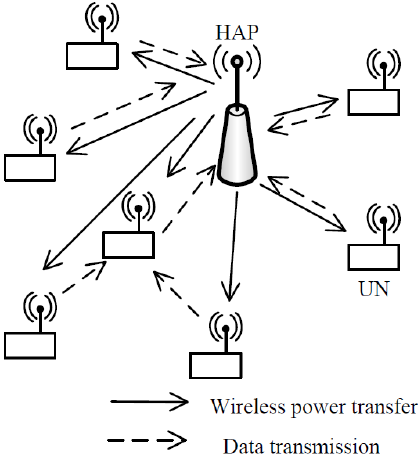
Figure 1. Model of a multi-hop wireless powered communication network.